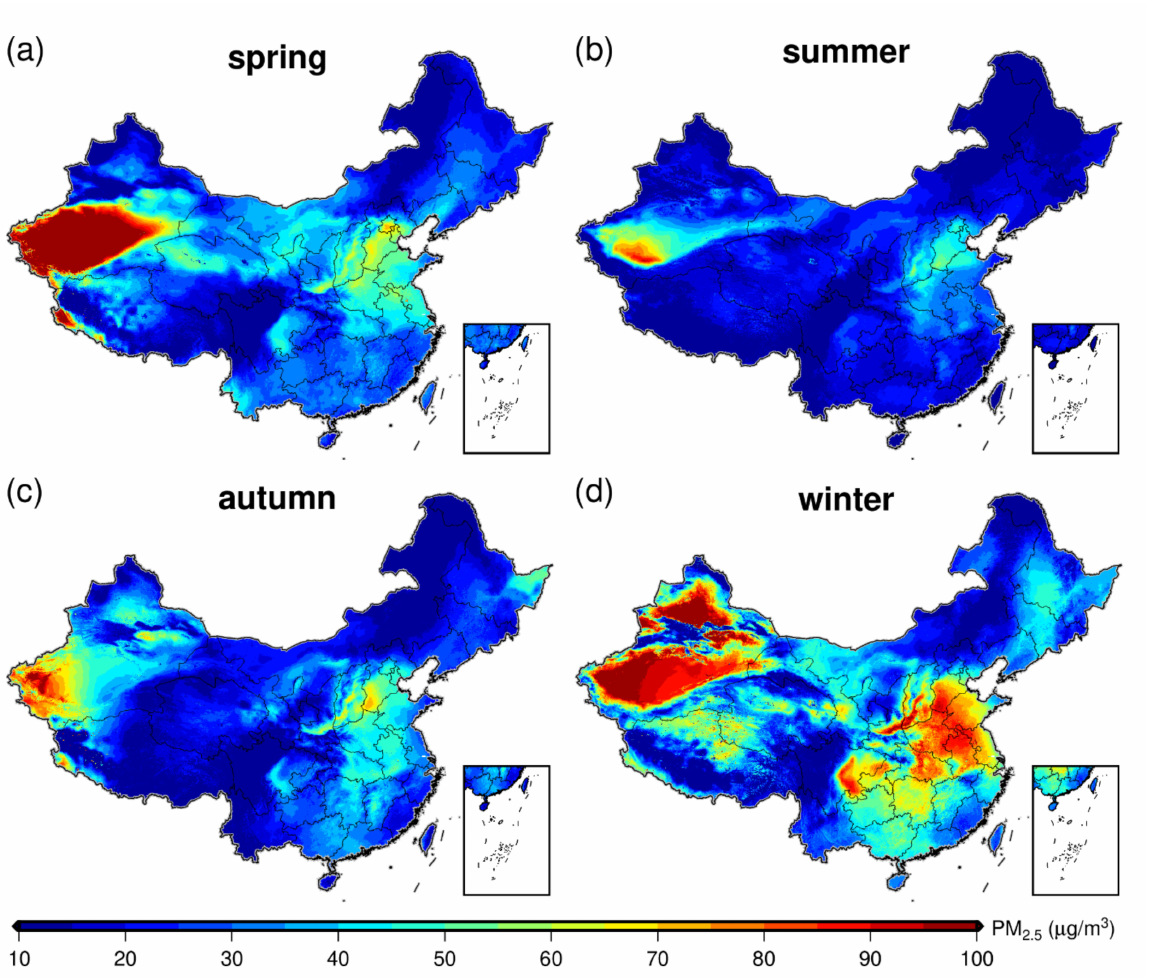
Figure 6. Seasonal variation of satellite-estimated PM 2.5 concentrations in China. ( a ) spring ( b ) summer ( c ) autumn ( d )